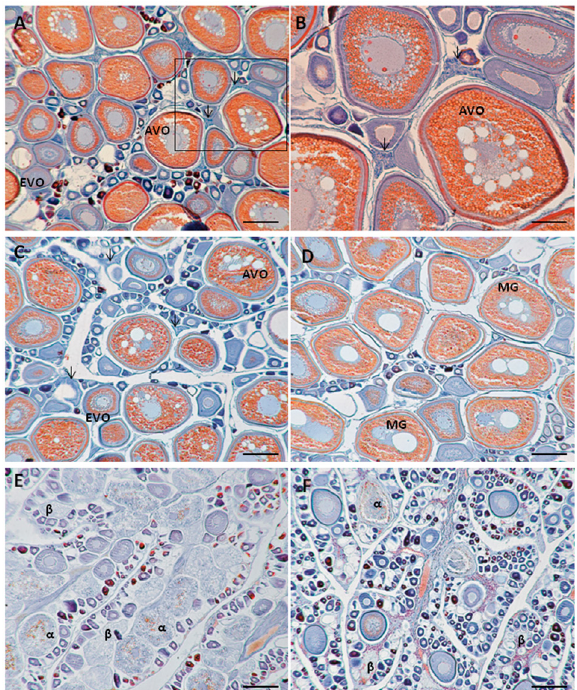
Fig. 6. – Microphotographs of spawning females. A. Ovary with early (EVO) and advanced (AVO) vitellogenic oocytes; arrows point to postovulatory follicles. B. Squared area in A, detail of postovulatory follicles (arrows show POFs) and AVOs. C. Ovary with vitellogenic oocytes and POFs. D. Ovary with migratory oocyte nucleus (MG). E and F. Ovary in regression after spawning, α and β atresia. Bar on images A, C, D and F=250 µm and on image B=100